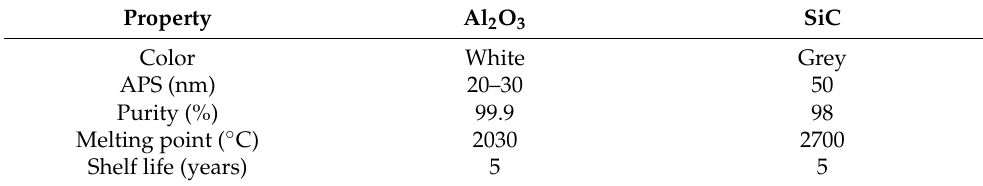
Table 3. Typical properties of